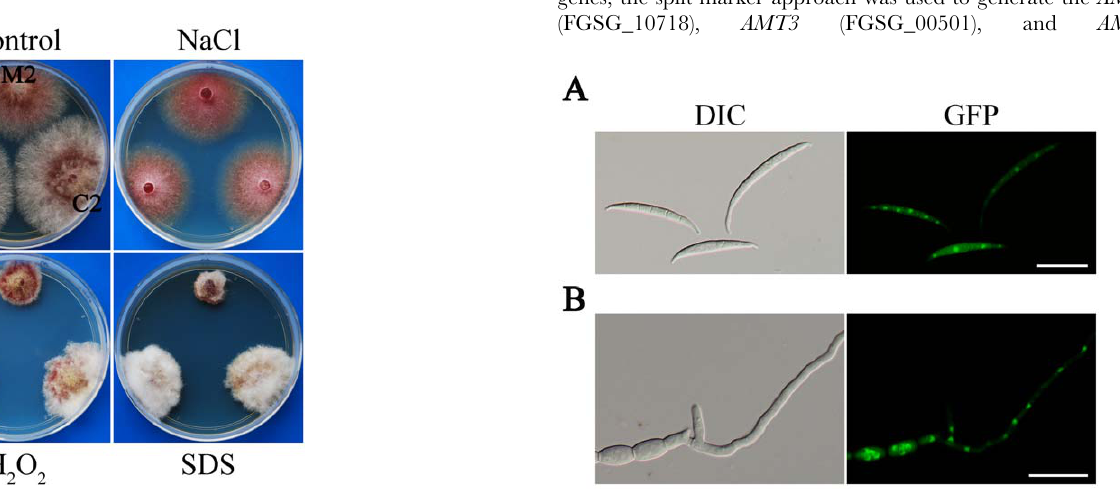
Figure 4. Assays for defects of the D amt1 mutant to different stresses. Cultures of the wild-type (PH-1), D amt1 mutant (M2), and D amt1/AMT1 (C2) strains grown on regular PDA or PDA with 0.7 M NaCl, 0.05% H 2 O 2 , or 0.01% SDS. Photographs were taken after incubation at